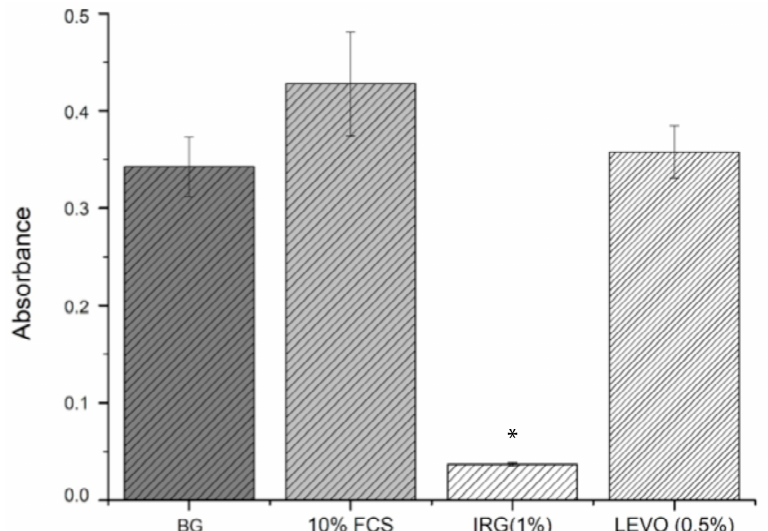
Figure 7. Absorbance data with standard error bars (n = 3) for resazurin assay against BG (background) 10% fetal calf serum (FCS), 1% IRG and 0.5% LEVO concentrations. BG, IRG (1%), LEVO (0.5) vs 10% FCS * p < 0.05.